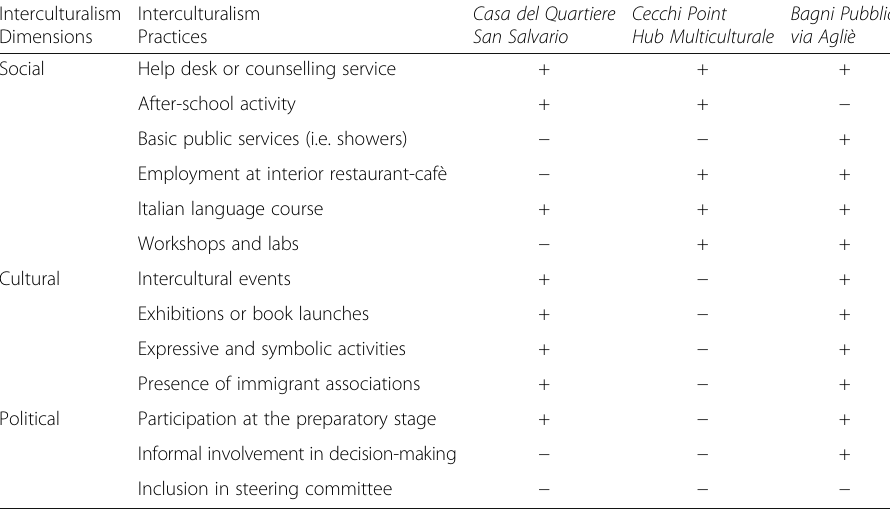
Interculturalism